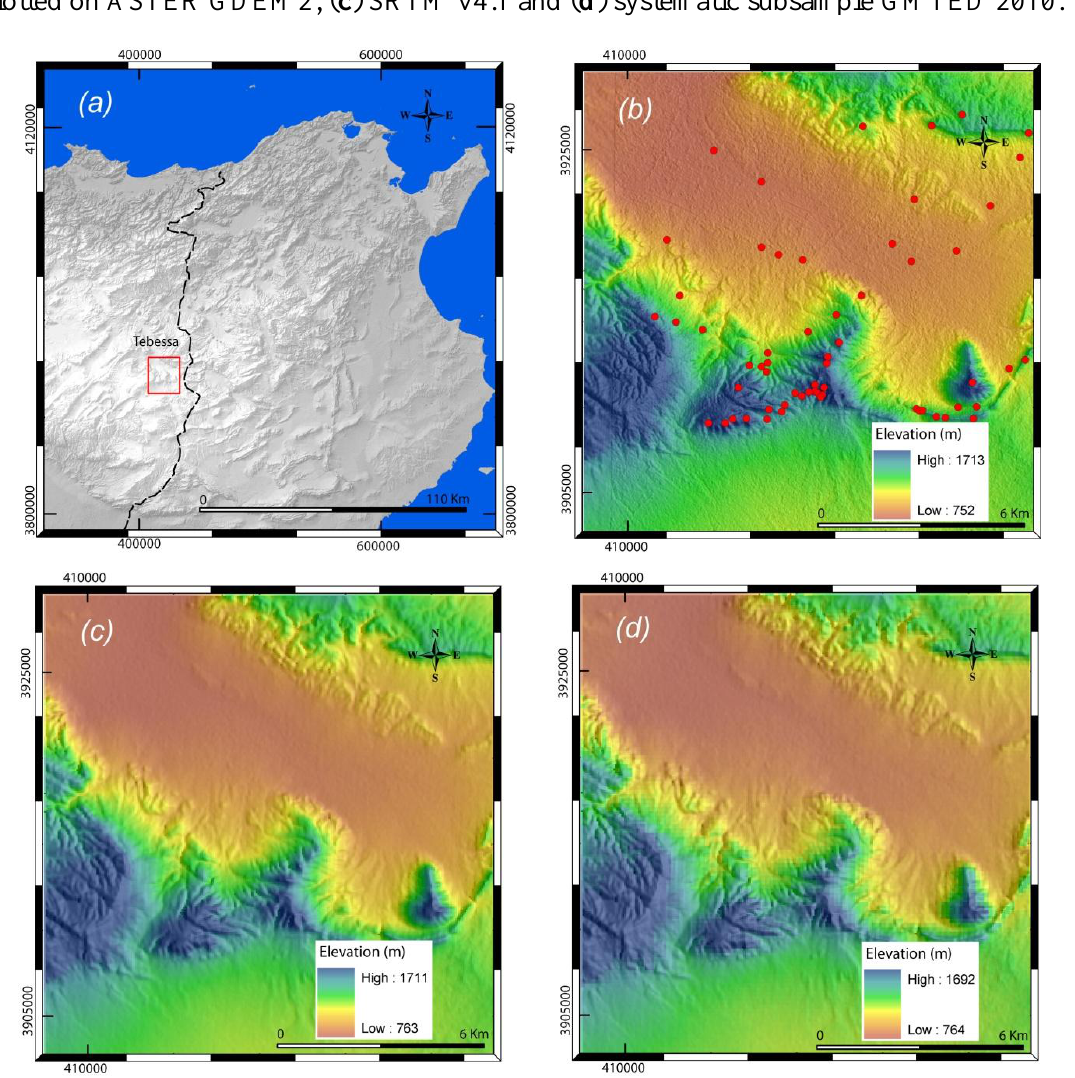
Figure 4. Data used for Tebessa test site: ( a ) location of Tebessa basin, ( b ) GNSS data plotted on ASTER GDEM2, ( c ) SRTM v4.1 and ( d ) systematic subsample GMTED